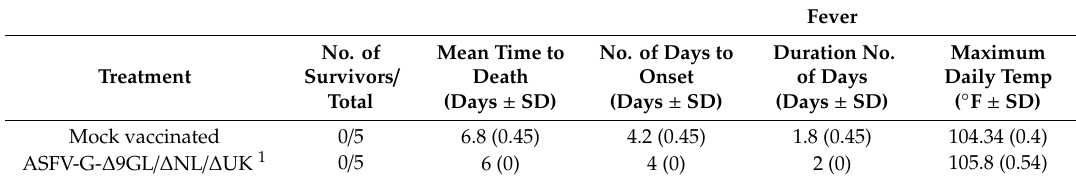
Table 2. Survival and fever response in animals infected with ASFV-G- ∆ 9GL / ∆ NL / ∆ UK and challenged 28 days later with 10 2 HAD 50 of parental